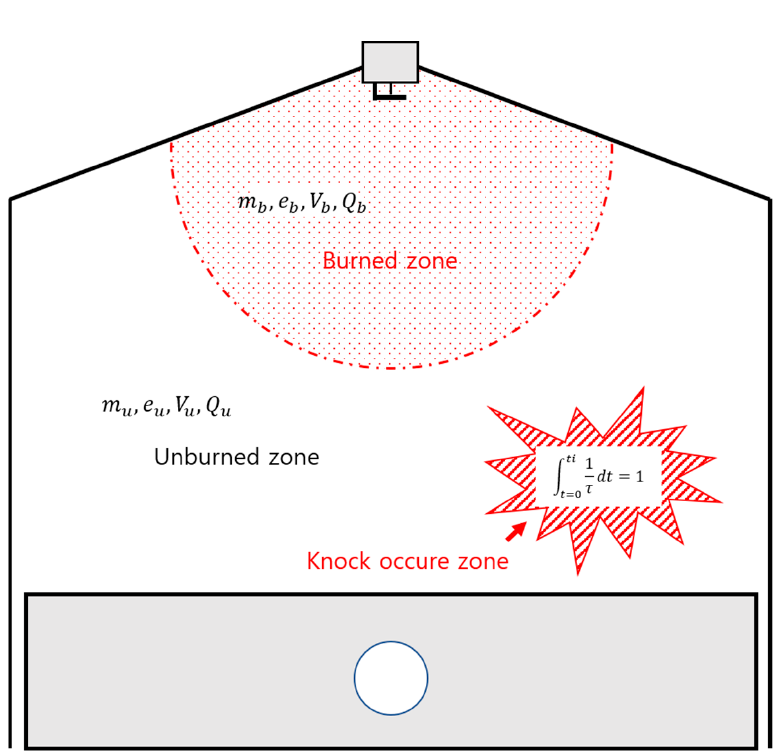
Figure 4. Two combustion zones and the induction time integral equation.